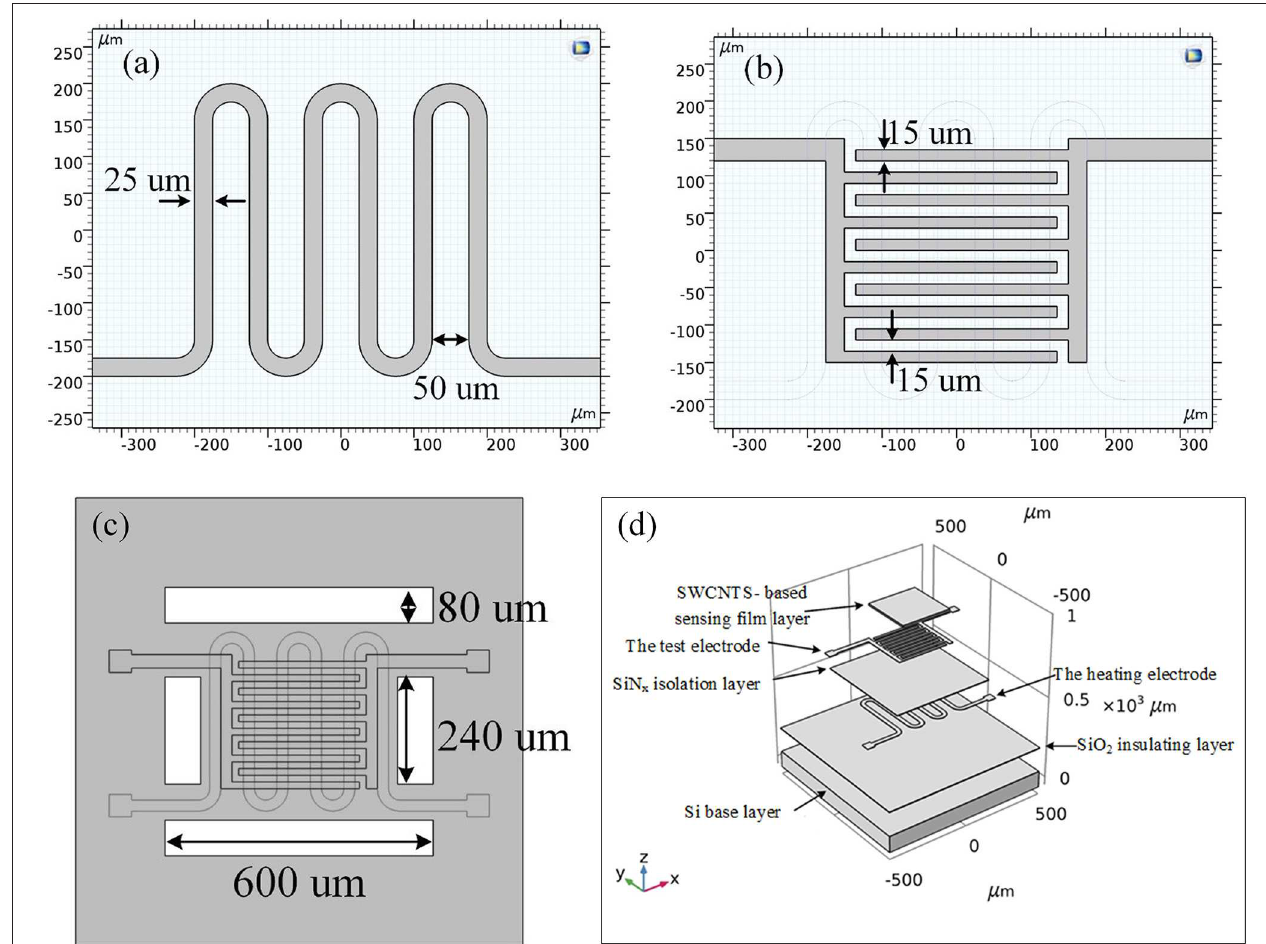
FIGURE 1 | (a–c) The 2D structure of the planar gas sensor. (d) The 3D structure of the planar gas